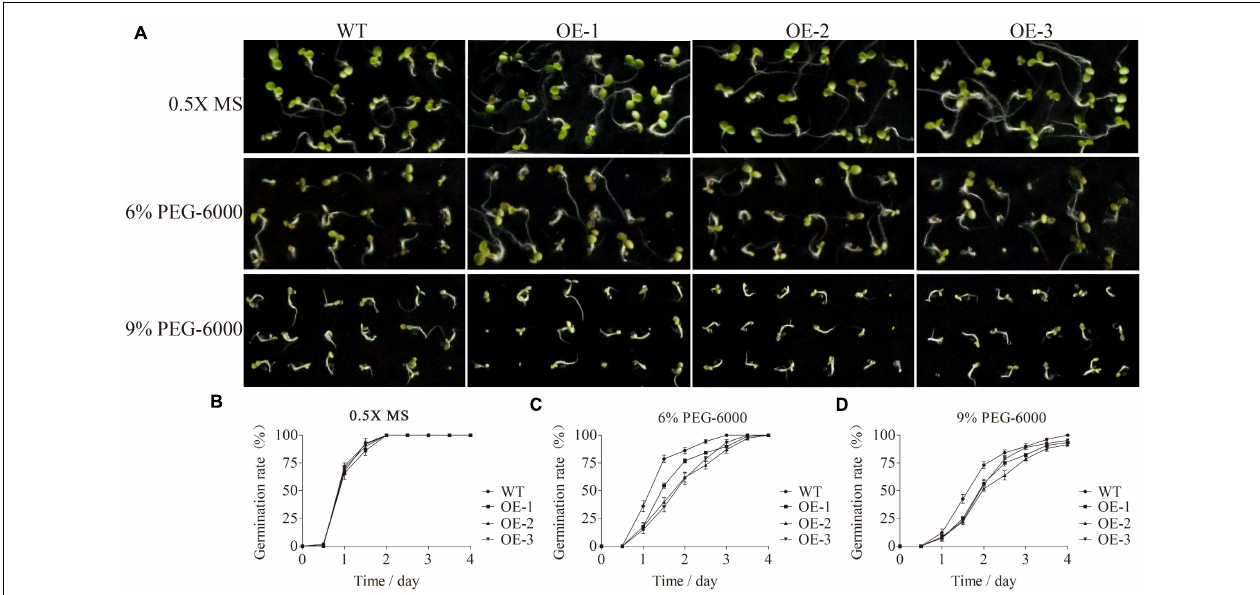
FIGURE 7 | Germination assays of wild-type (WT) and SiMADS51 transgenic Arabidopsis seeds under PEG-6000 treatments. (A) Phenotypes of WT and SiMADS51 transgenic Arabidopsis seeds on 0.5X Murashige and Skoog (MS) medium with or without 6% PEG-6000 and 9% PEG-6000, respectively. (B–D) Germination rates of WT and SiMADS51 transgenic Arabidopsis seeds on 0.5X MS medium, 0.5X MS medium containing 6% PEG-6000, and 0.5X MS medium containing 9% PEG-6000 at different time points. Date for each time point are means of three biological